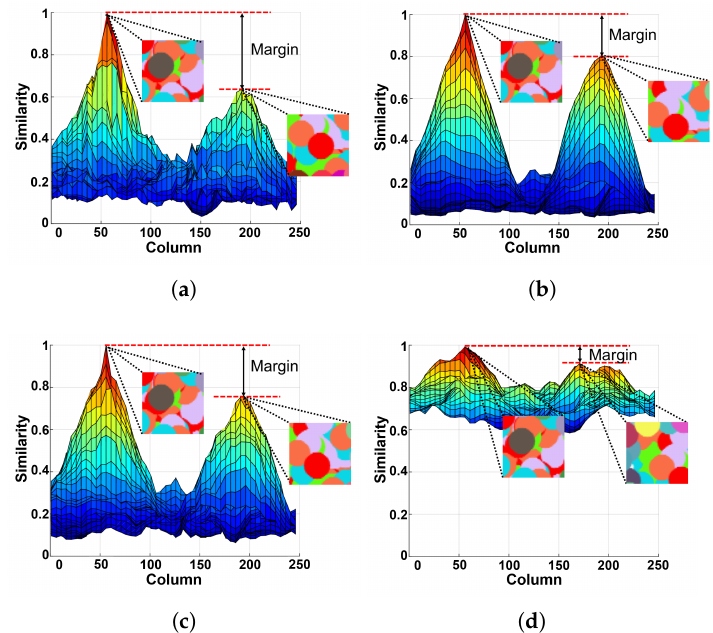
Figure 8. Projected profiles of similarity (No noise σ = 0). ( a ) ABC. ( b ) CI. ( c ) CCH. ( d )